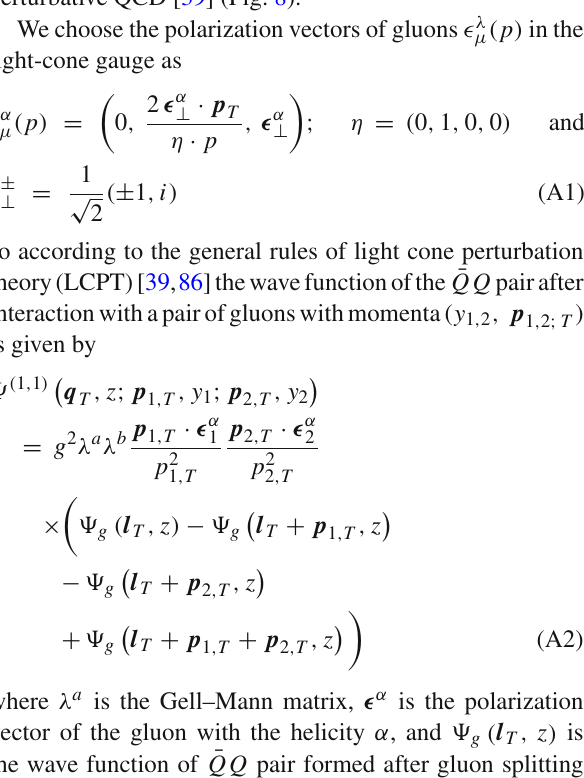
(cid:2) p 1 , T , p 2 , T